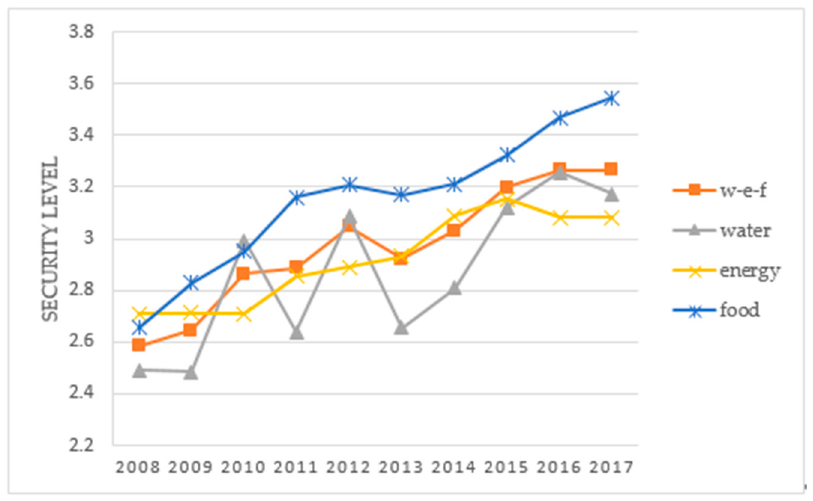
Figure 3. Trend graph of system security in the Yangtze River Economic Belt during 2008–2017.